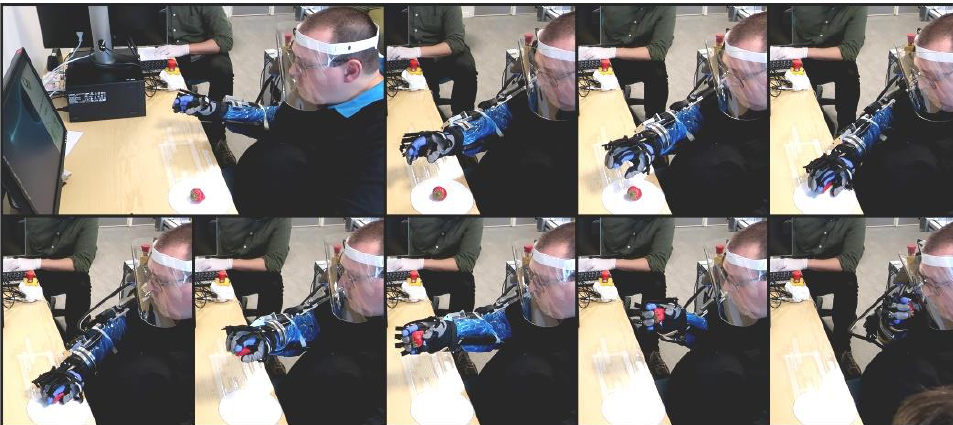
Figure 11. Image series of the strawberry task being performed by a user. The images show the initial approach, turn of the wrist, grasping and transfer to the mouth. Note: the blue plastic sleeve on the arm and the purple glove underneath the exoskeleton glove are only present due to the Covid-19 outbreak happening during the experiments. Table 4. Metrics for the tests with able-bodied individuals and users. Mean and standard deviations of each metric of the described tests for both individuals with tetraplegia and able-bodied individ- uals.